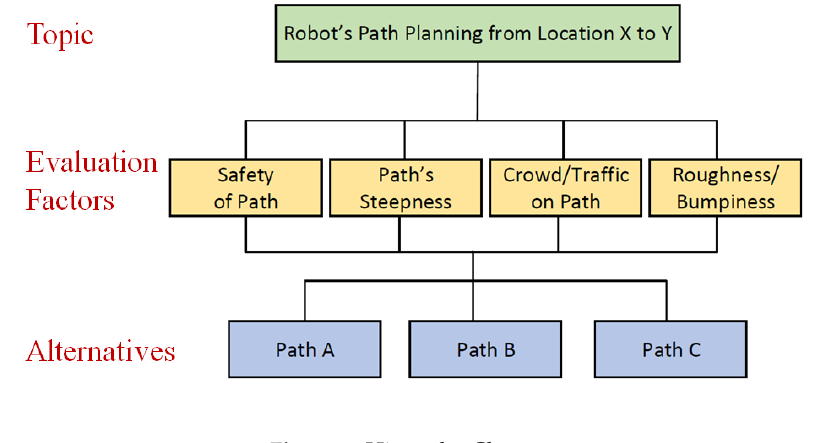
Figure 2. Hierarchy Chart.